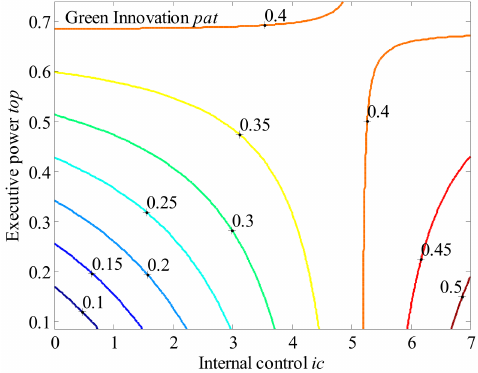
Figure 6. Regulatory effect of executive power. Table 9. Heterogeneity test of executive power and government